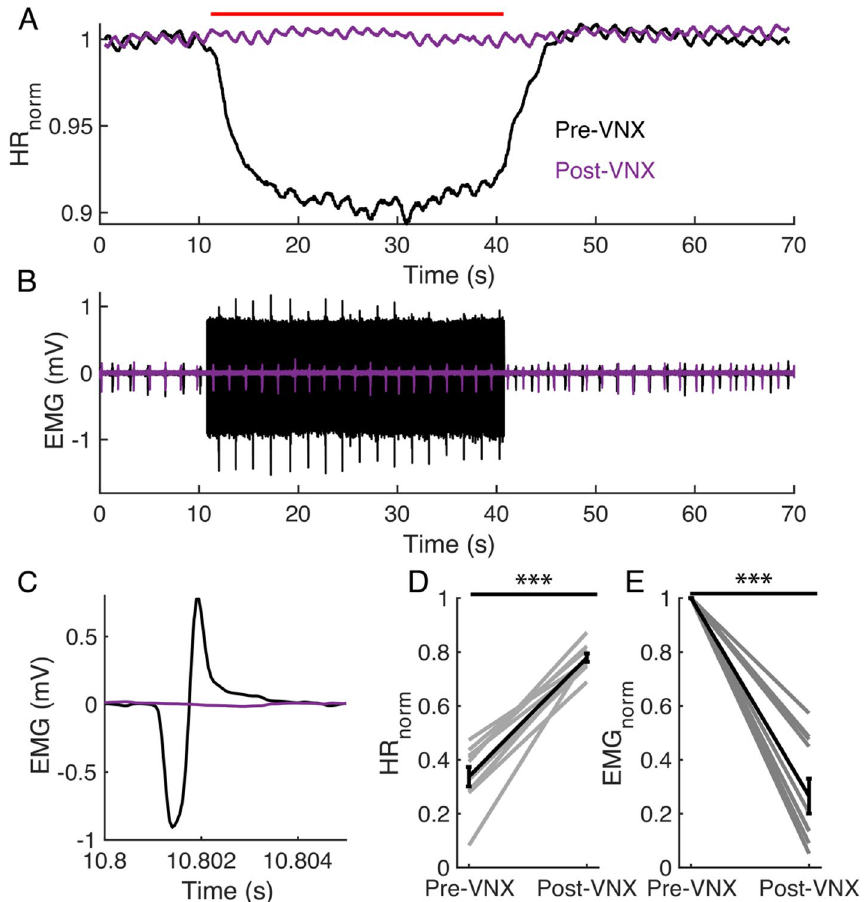
Fig. 6 Vagotomy (VNX) distal to the stimulation cuff abolished VNS-evoked responses. A - B Example heart rate (HR) and EMG responses. Stimulation was applied at 20 Hz at bradycardia threshold (BCT) determined pre-VNX from t (purple). B EMG norm pre-VNX (black) and post-VNX (purple). C EMG response to a single stimulation pulse pre- and post-VNX. D HR norm pre- and post-VNX. E EMG norm pre- and post-VNX. *** p < 0.0001, n